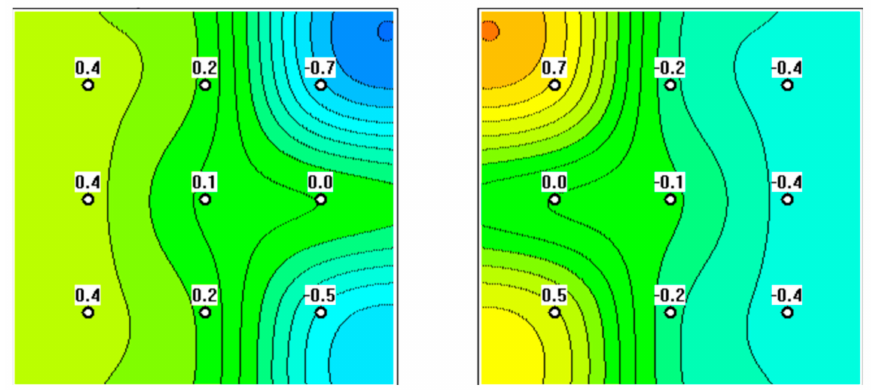
Figure 2. MWR performed on a 72-year-old patient. Signs of hyperthermia in the projection of the left ovary can be seen, putting the patient in the at-risk